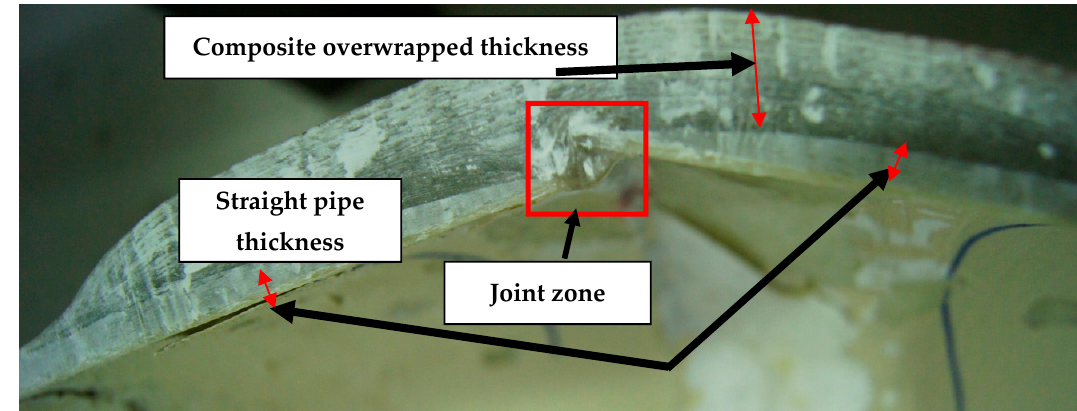
Figure 2. Elbow cross-section shows an improper joining between the composite elbow sections.